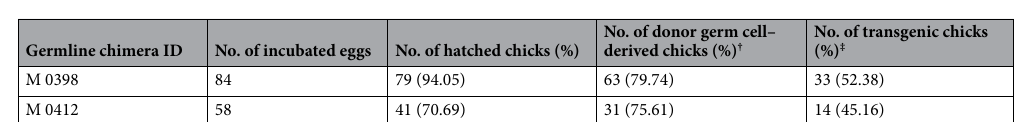
Figure 2. Effect of busulfan in embryonic gonads after MGSTII-tg PGC transplantation. ( A ) In vivo effect of chicken PGCs under busulfan treatment. Endogenous PGCs were detected by DAZL immunostaining in HH28 embryonic gonads with or without busulfan treatment. Scale bars, 100 μm. ( B ) Migration assay of MGSTII-tg and GFP-tg PGCs treated with 1 μM busulfan. Approximately 1,000 GFP-tg or MGSTII-tg PGCs were injected into the dorsal aortas of chicken embryos at HH 13–16. Fluorescent cells were observed and counted in recipient embryonic gonads at HH 28. Scale bars, 100 μm. ( C ) Number of PGCs migrated to the gonads of HH 28 embryos injected (i.v.) with 1,000 PGCs at HH 13–16 (mean ± SD; n = 3 for each group). * P < 0.05, ** P < 0.01, *** P < 0.001.